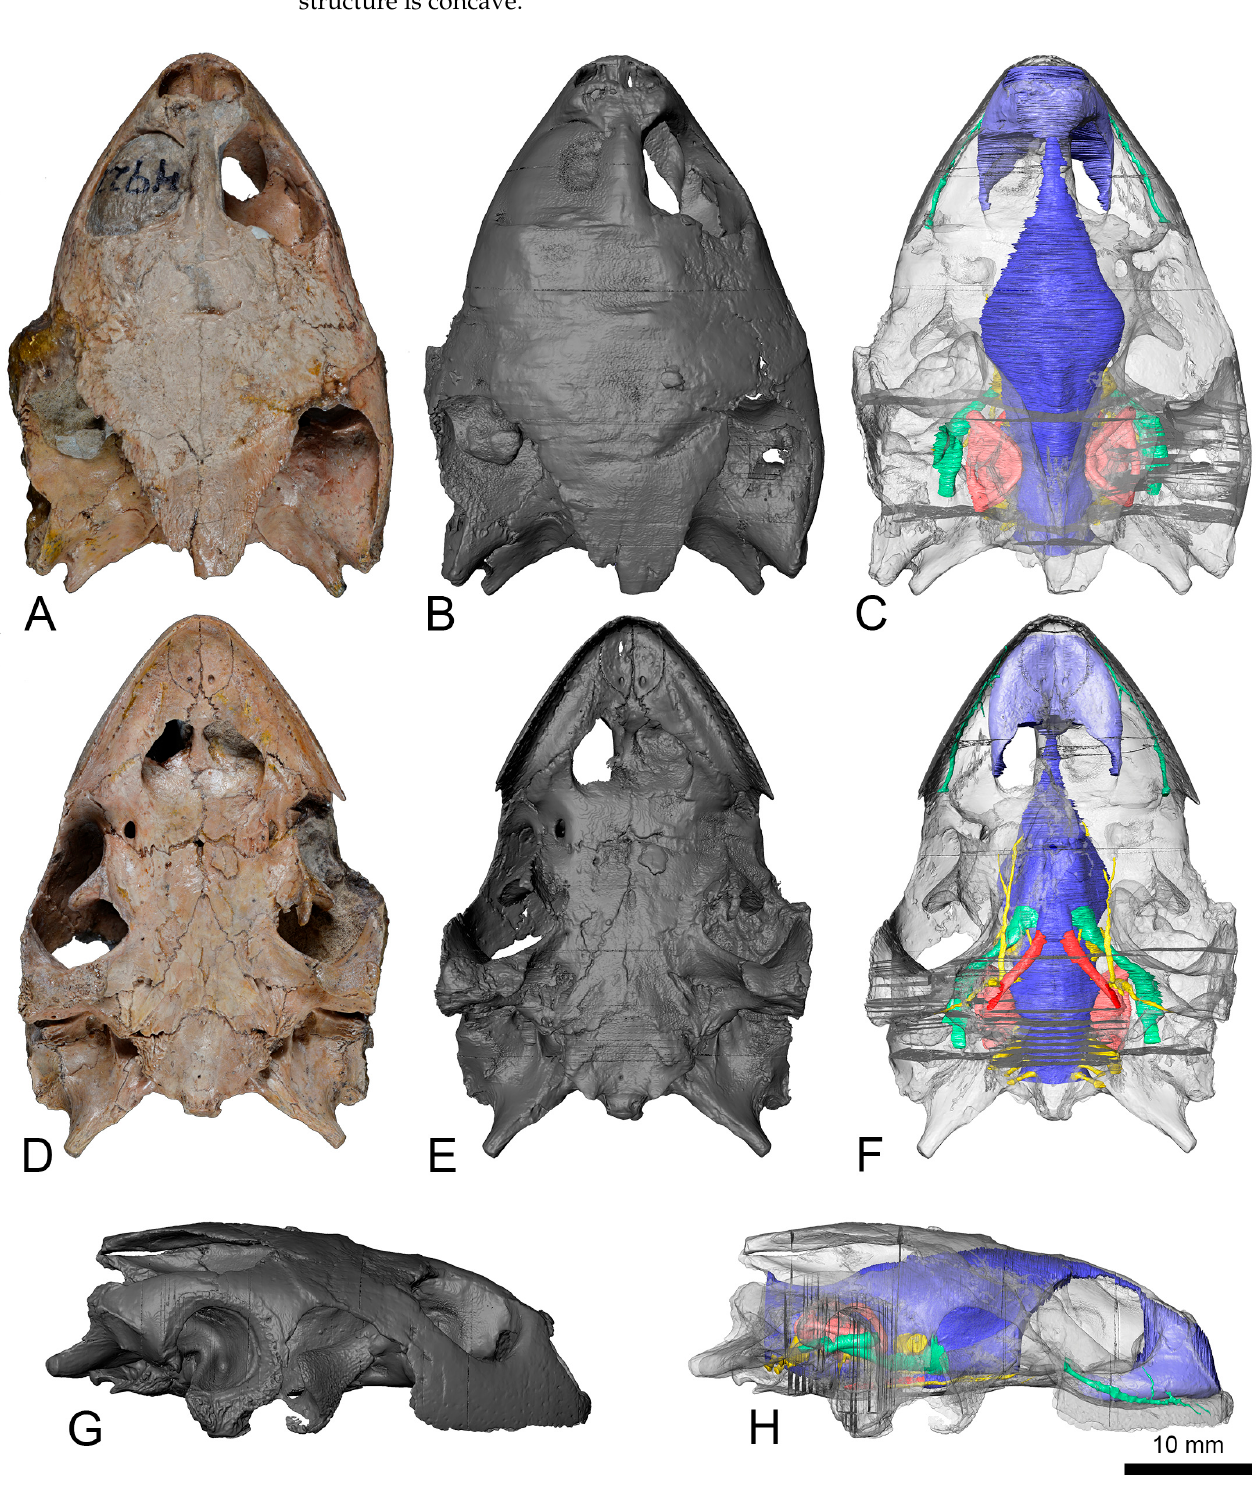
Figure 1. FR 4922, skull of the holotype of Euraxemys essweini (Euraxemydidae) from the Albian of Araripe Basin in Brazil. Photographs reproduced with permission from S. Tränkner, Senckenberg ( A , D ); rendered three-dimensional reconstruction ( B , E , G ); and transparent rendered skull including the three-dimensional reconstruction of the neuroanatomical structures in dorsal ( A – C ), ventral ( D – F ), and right lateral ( G , H ) views.